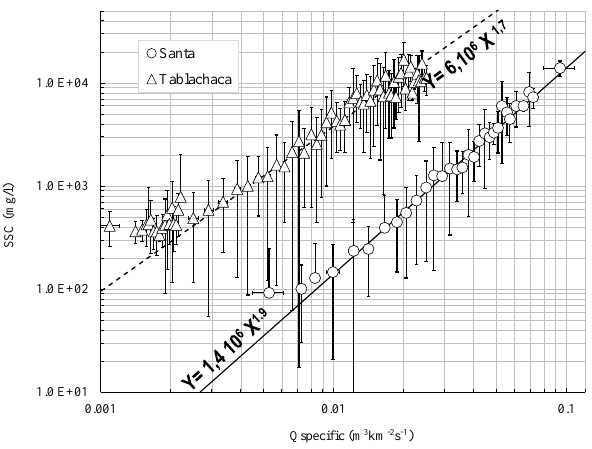
Fig. 7. Log–log relation of suspended sediment concentration (SSC, mgL − 1 ) and corresponding specific water discharge ( Q s ) (m 3 km − 2 s − 1 ) at the Tablachaca and Santa stations. Solid and dashed lines are the power-law best fit for all data collected in the Santa and Tablachaca rivers, respectively. Bars represent the monthly variations.